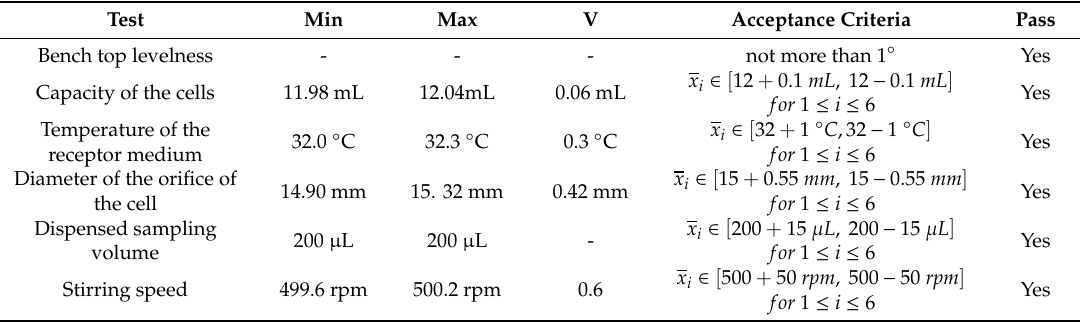
Table 1. Pre-defined acceptance criteria and results mechanical validation.